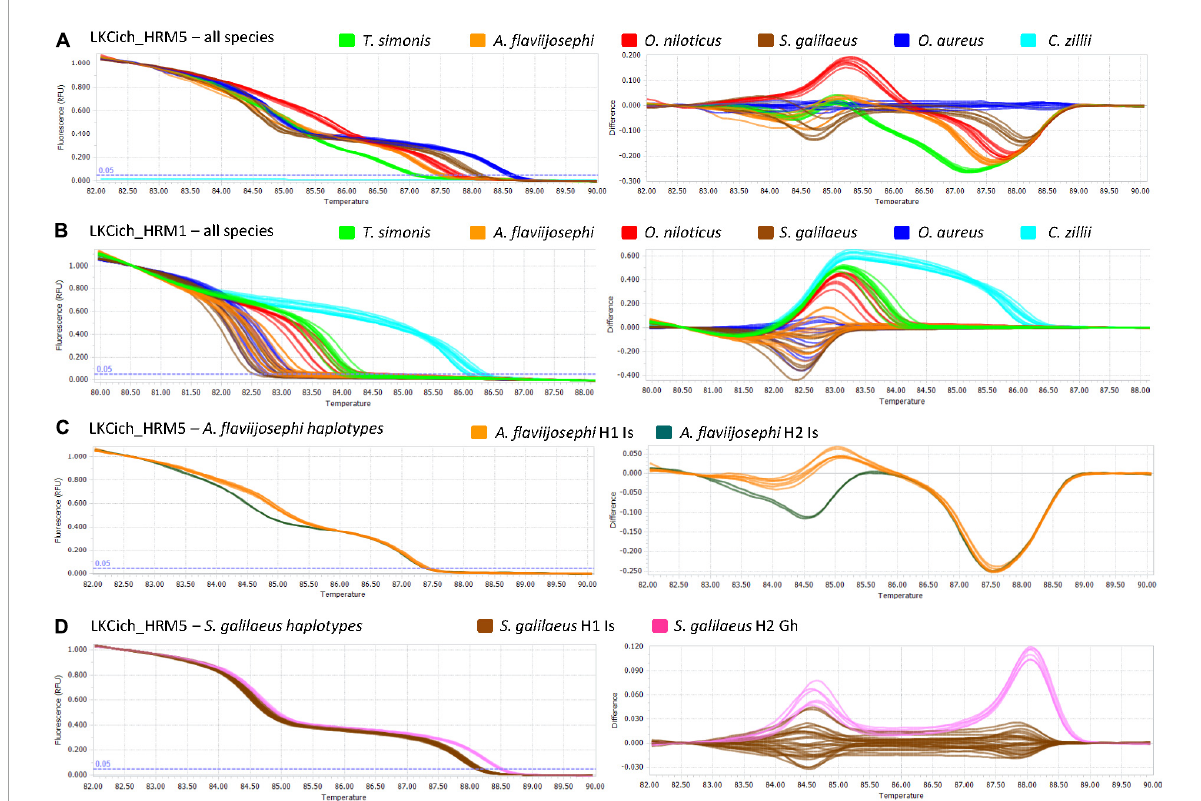
FIGURE3 Bar-HRM analyses of the reference sample set of six cichlid species. In all panels, the melting curve profiles (fluorescence level as a function of melting temperature) are shown on the left and the differences plots (difference in fluorescence as a function of melting temperature) on the right. For each panel, curves of different species are shown in different colors as indicated in the panel legend. (A) . Results obtained by primer pair LKCich_HRM5 for samples of all six species. Each line is an individual replicate. Note the difference in curve shape among species in contrast to the similarity among individuals of the same species even if they have different haplotypes. Coptodon zillii samples are not amplified as reflected by light blue flat lines on the left melting curve plot. (B) . Results obtained by primer pair LKCich_HRM1 for samples of all six species. For these primers the most notable difference in melting curves is for C. zillii . More subtle differences could be found also between additional species, allowing independent verification for some species in addition to curves from LKCich_HRM5. (C) . Results obtained by primers LKCich_HRM5 for samples of Astatotilapia flaviijosephi with different haplotypes that were both found in Israel (H1 Is and H2 Is). (D) . Results obtained by primers LKCich_HRM5 for samples of Sarotherodon galilaeus with different haplotypes (H1 Is from Israel and H2 Gh from